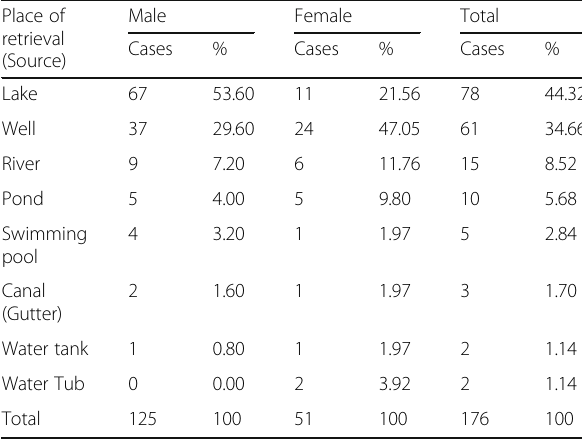
Table 5 Distribution of drowning deaths as per place